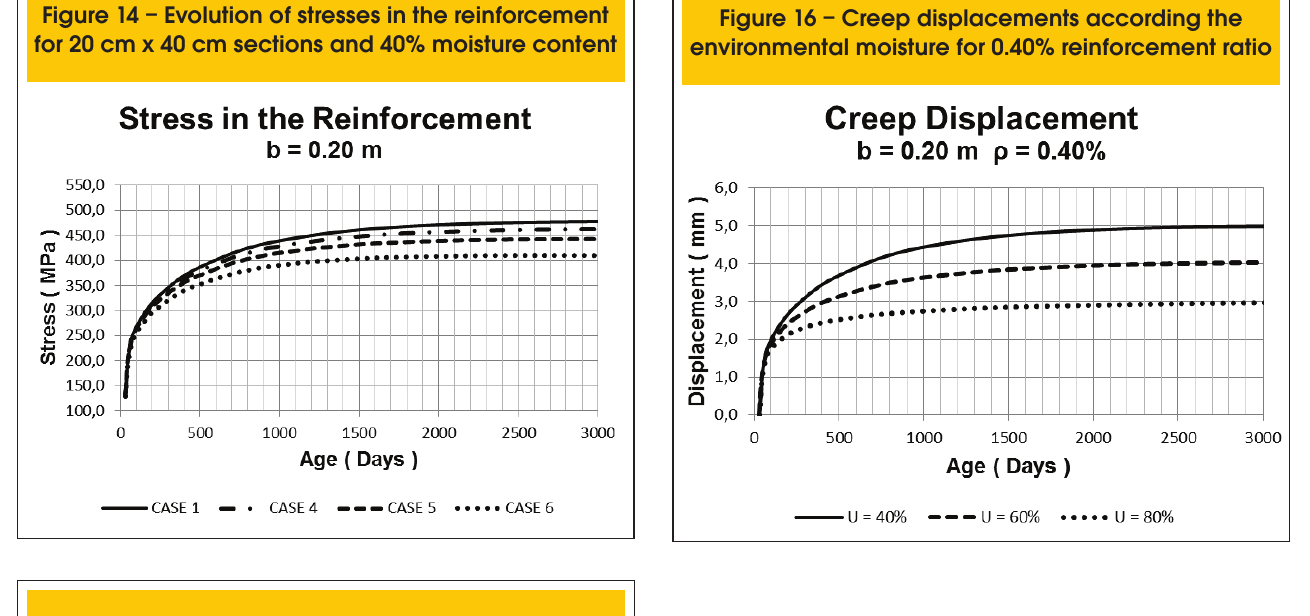
Figure 15 – Creep displacements according the reinforcement ratio for 40% moisture